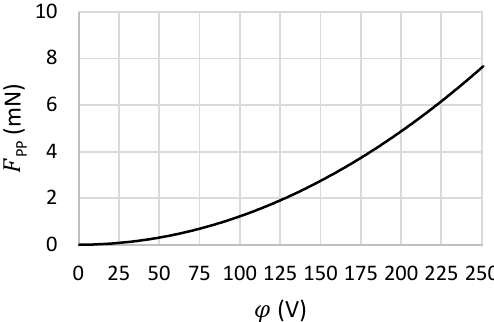
Figure 3. Theoretical relation between the applied voltage, ϕ , in the parallel plates and the correspon- dent force, F PP .